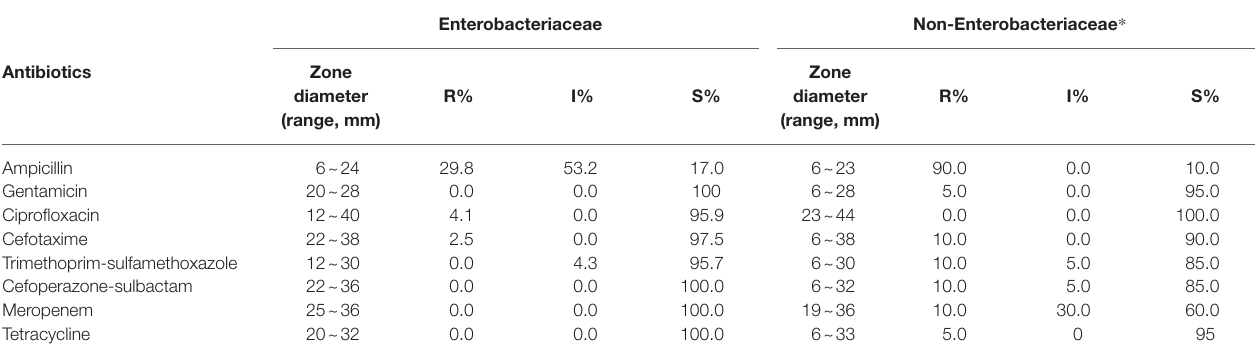
TABLE 2 | Antimicrobial resistance profiles of culturable bacteria from red swamp crayfish.